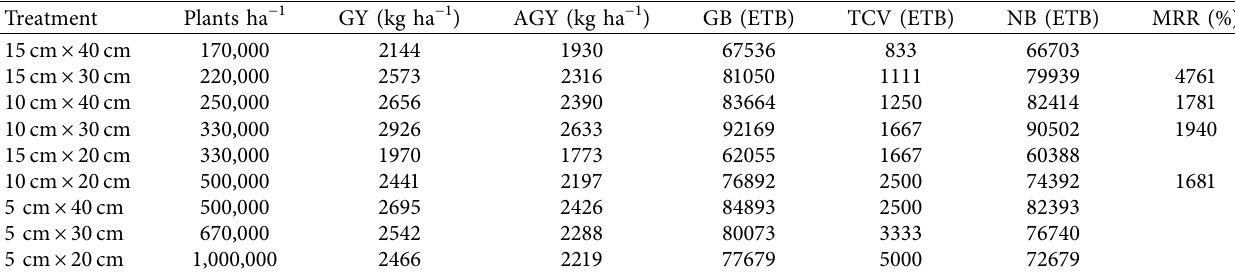
Table 5: Economic analysis for inter-row and intrarow spacing of chickpea over site and year.